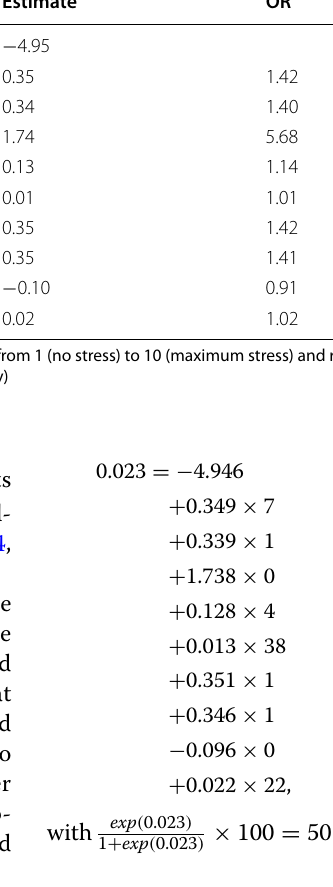
M ABESS (left side) and M MBRP (right =